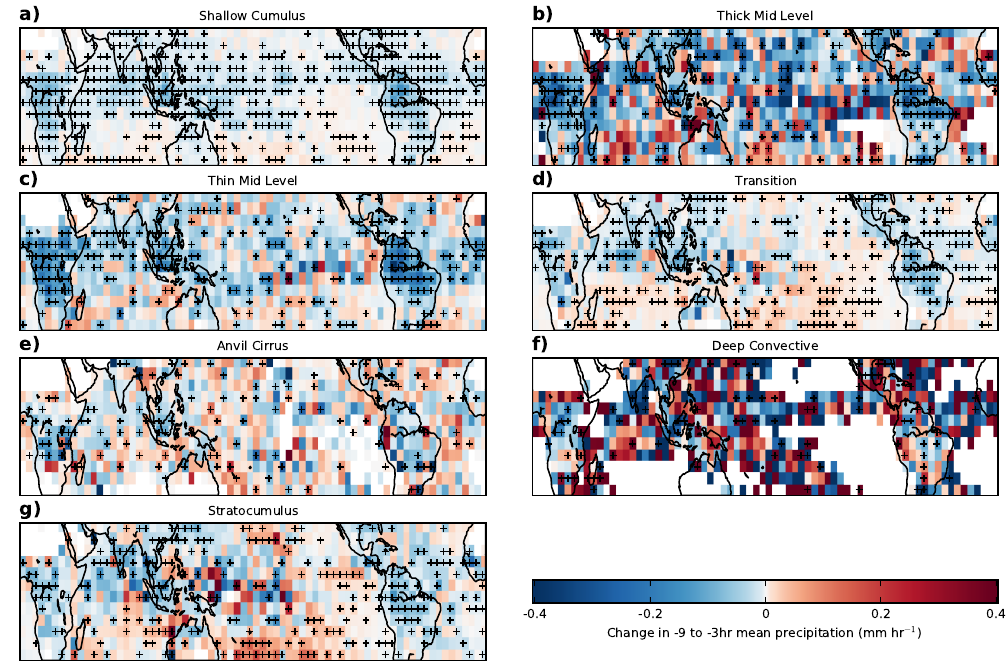
Figure 5. Mean precipitation difference between the high and low AI populations from T − 9 to T − 3 ( T + 0 at 13:30LST) over the period 2003–2009. Red indicates an increase in precipitation at high AI. Crosses indicate 95% statistical